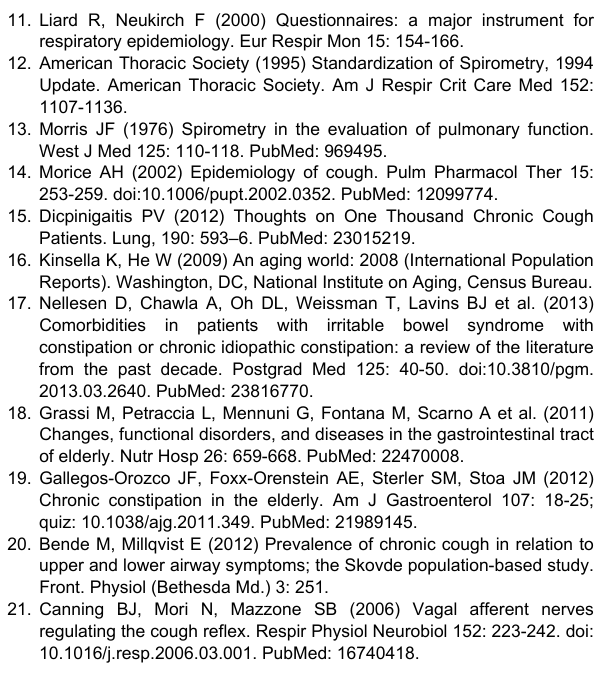
Logistic regression models for cough and comorbidity relationships among the subjects without abnormal chest radiographs and ACE inhibitor/codeine